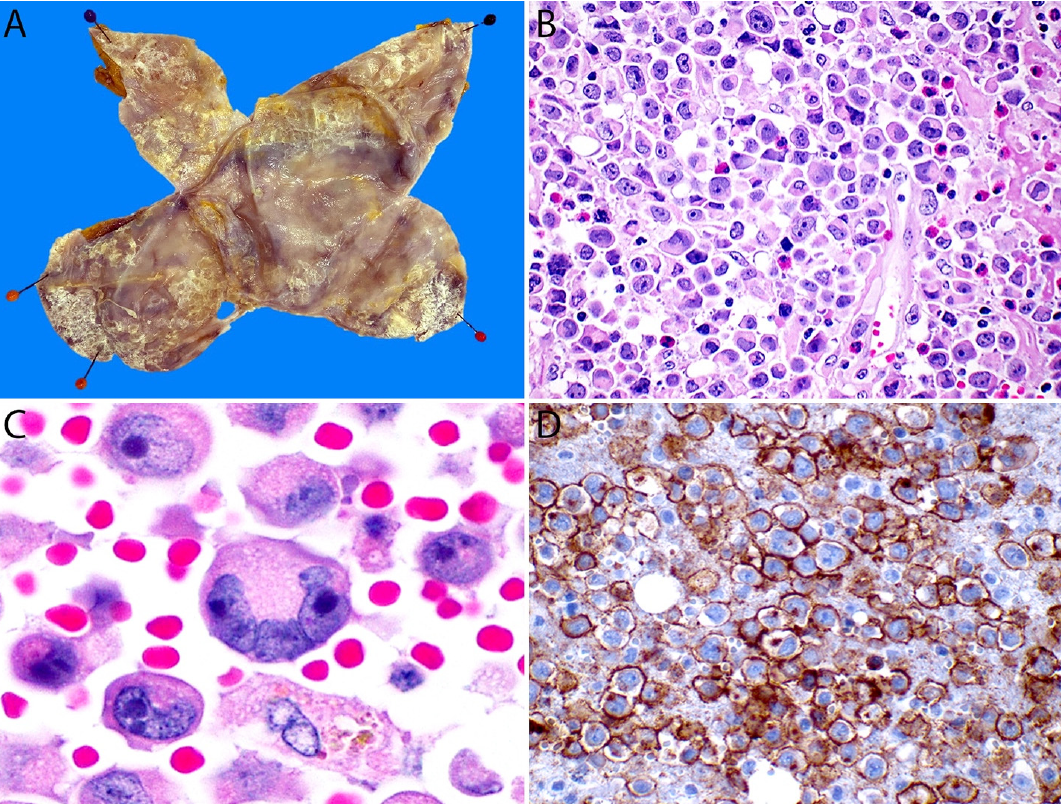
Figure 16. Breast implant-associated ALCL. ( A ) Opened breast implant capsule pinned to a flat surface (after overnight fixation). Note the multiple areas with a fibrinous/necrotic appearance on the luminal surface that correspond to collections of lymphoma cells. ( B ) The cell block obtained from the effusion contains numerous anaplastic large lymphoma cells. ( C ) At high magnification, the large lymphoma cells show a pleomorphic and hypechromatic nucleus with abundant eosinophilic cytoplasm. A “hallmark” cell is also seen (bottom). ( D ) The CD30 immunostain shows membranous and paranuclear dot (Golgi) labelling in virtually all these cells.